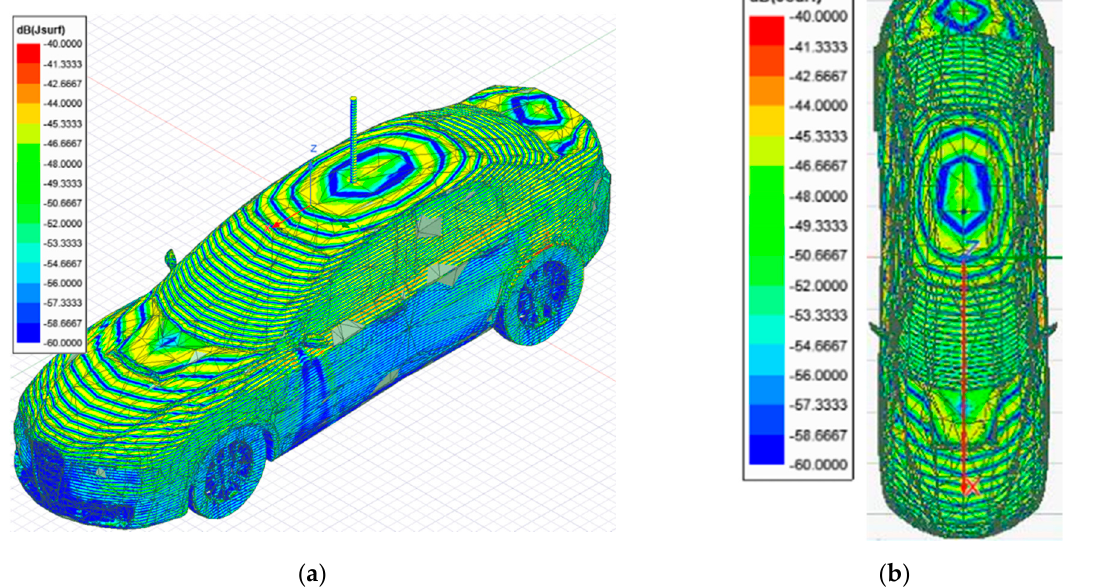
Figure 3. Surface current distribution imaging generated by Ansys HFSS software for a 10 cm long vehicle with antenna (ON state), illuminated at 300 GHz: ( a ) 3D view of the surface current distribution of the vehicle; ( b ) top view of the surface current distribution.